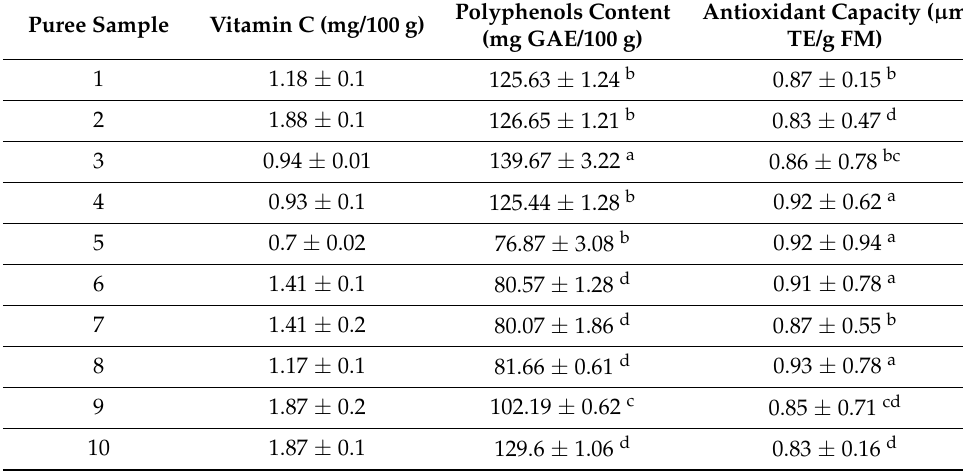
Table 5. Vit. C, TPC and AC determination in sterilized